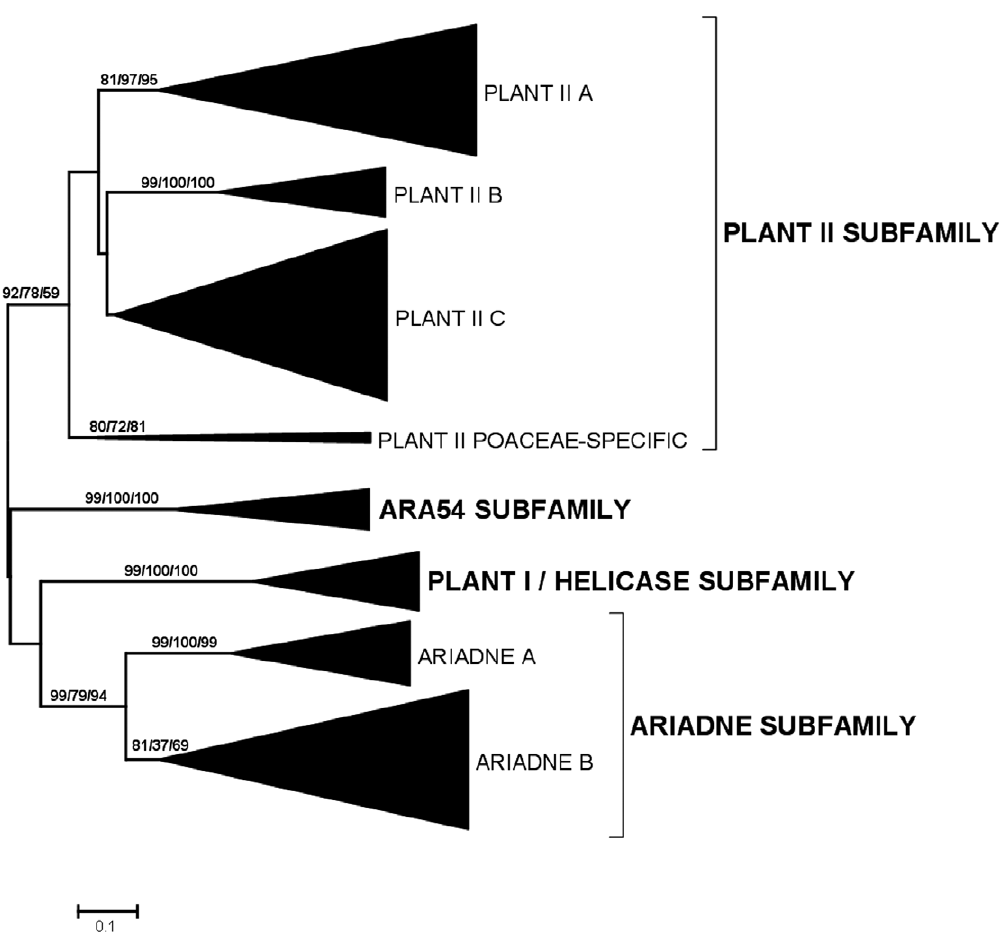
Figure 2. Dendrograms for RBR sequences of angiosperms and gymnosperms. Bootstrap support and number of sequences indicated as in Figure 1. Bootstrap values (in percentages) for highly supported branches are indicated.